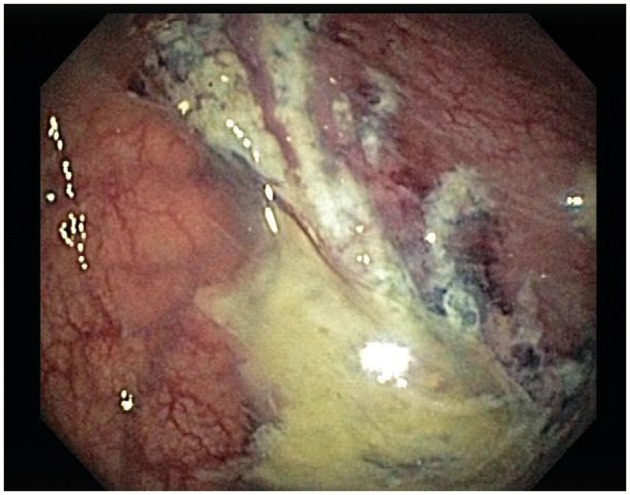
Endoscopic findings